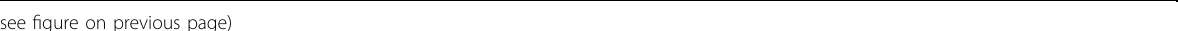
Fig. 2 Clinical characteristics of the two groups. a , b Comparative quanti fi cation of six antibody categories between the LC and SC groups. Number of samples collected for each week: 10 SC and 8 LC in week 1, 16 SC and 13 LC in week 2, 16 SC and 13 LC in week 3, 11 SC and 15 LC in week 4, 13 SC and 9 LC in week 5, 10 SC and 11 LC in week 6, 8 SC and 5 LC in week 7, 9 SC and 9 LC in week 8, 8 LC in week 9; total samples: 93 from 17 SC patients, and 91 from 19 LC patients. The pro fi les of the serum anti-S, anti-RBD, and anti-N IgM ( a ) and IgG ( b ) between the two groups along time. Orange asterisks mean signi fi cant variance over 8 – 9 time points in the SC group (one-way ANOVA). Purple asterisk means signi fi cant variance over 8 – 9 time points in the LC group (one-way ANOVA). Black asterisks show the interactional difference between time points and LC/SC group (two- way ANOVA). * P < 0.05; ** P < 0.01; *** P < 0.001. c Flow cytometry analysis of immune cells between the SC and LC patients. 22 samples from 17 LC patients and 30 samples from 17 SC patients were analyzed. Flow cytometry analysis of lymphocytes, CD4 + cells and CD127 – CD25 + Treg cells of two representative patients ( P -value from Welch ’ s t -test). The bean plots show the comparison between the two